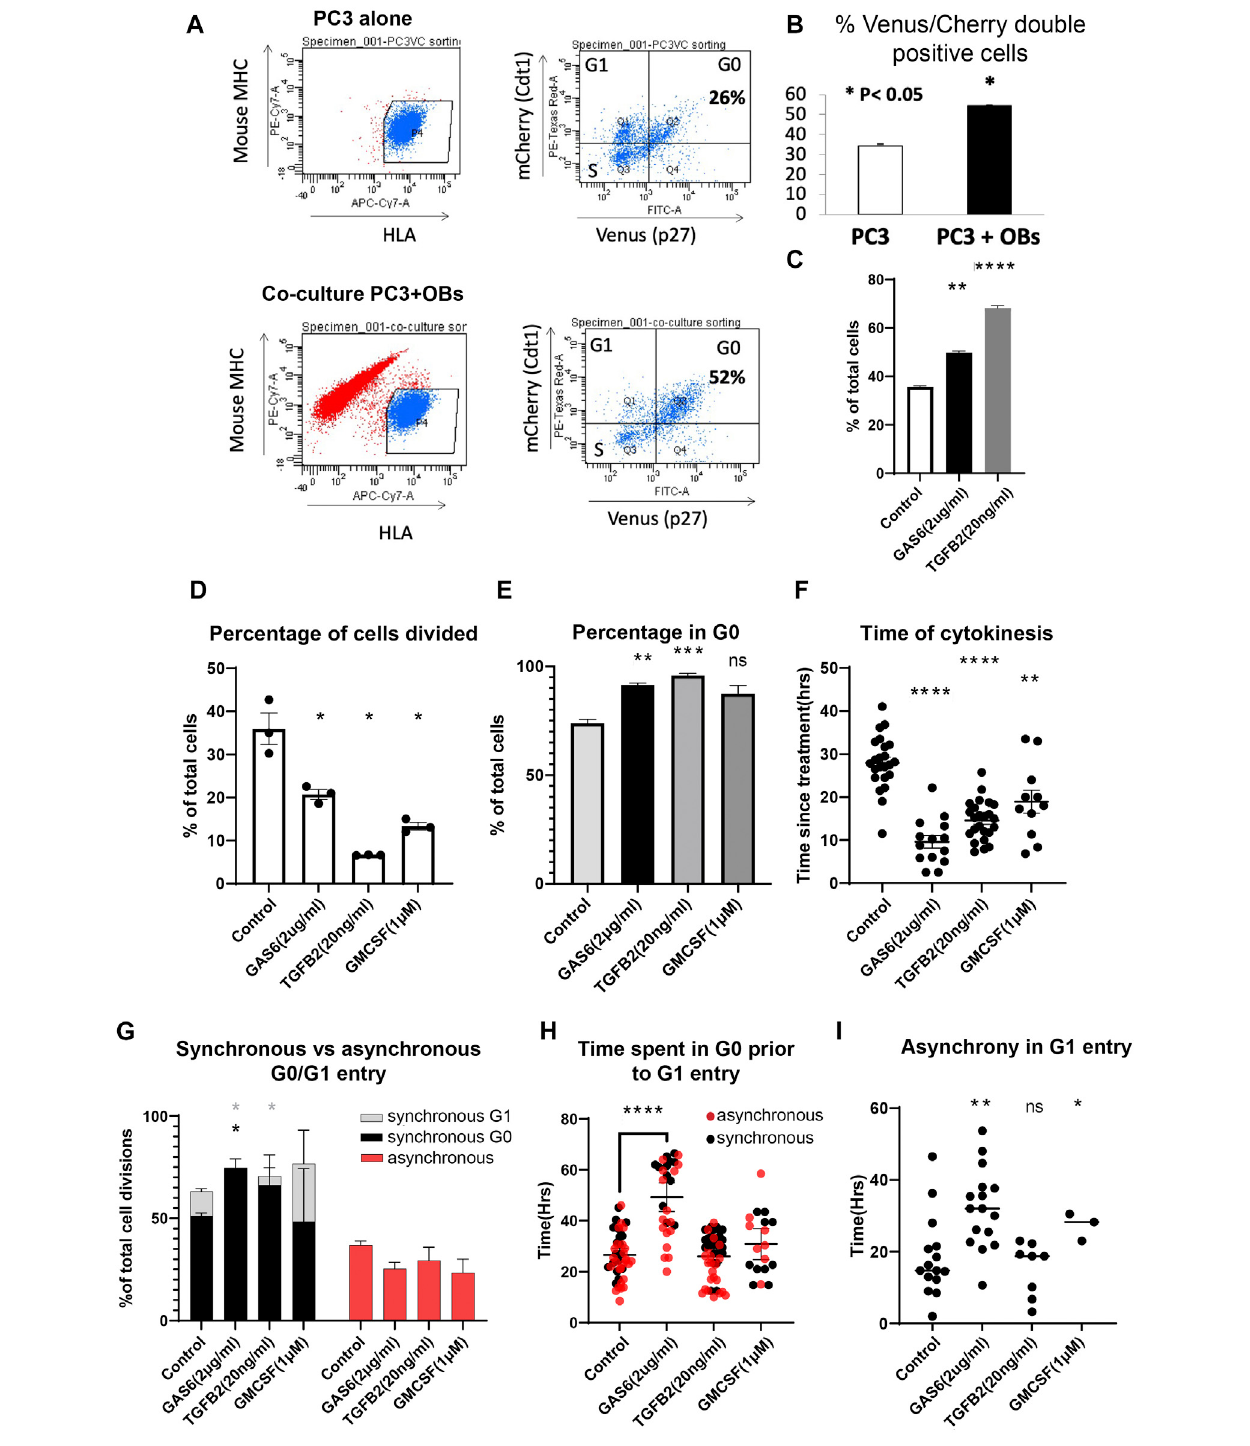
FIGURE3| Tumordormancysignals in fl uencequiescenceandasynchronousproliferation-quiescencedecisions. (A) PC3 Venus/Cherrycellswereeithercultured alone or co-cultured with mouse osteoblasts, which were excluded from cell cycle analysis by negative human HLA staining and positive anti-mouse MHC staining. (B) PC3 co-culture with osteoblasts induced asigni fi cant increase in G0 cells under full serum conditions. (C) PC3 cells treated with Gas6 or TGFß2also exhibit a signi fi cant increaseinG0cells,measuredby fl owcytomtery. (D) G0-VenusreporterdynamicsweretrackedusingthecellhotelforcellsexposedtoGas6( n (cid:2) 583),TGFß2( n (cid:2) 1,576) or GM-CSF ( n (cid:2) 330) or vehicle only controls ( n (cid:2) 336). Experiments were performed at least in triplicate. Gas6, TGFß2 and GM-CSF signi fi cantly decreased the